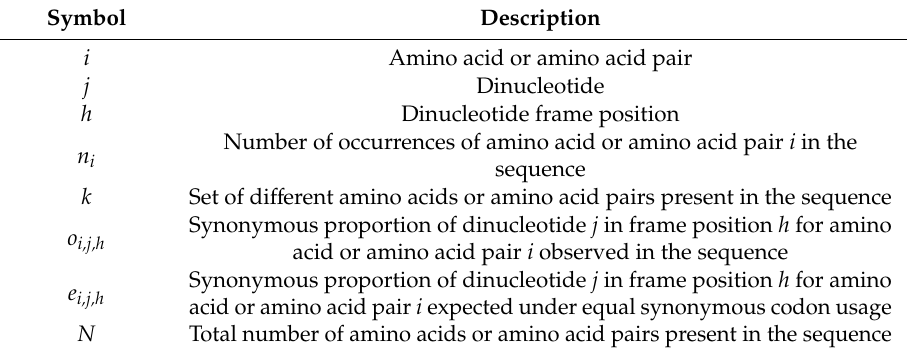
Table 1. Notation used to define SDU and